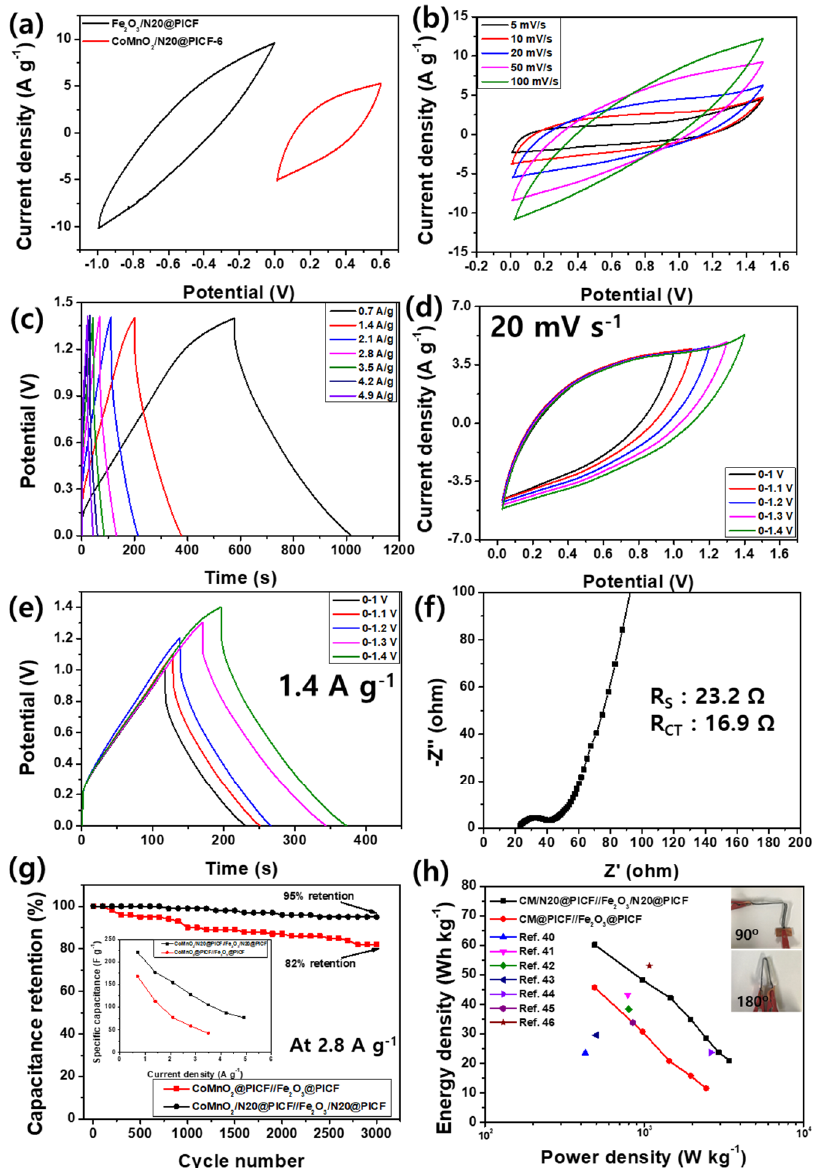
Figure 7. CV curves ( a ) of the cathode and anode materials at 20 mV s − 1 , CV curves ( b ) of the asymmetric supercapacitors (ASC) device at various scan rates, GCD curves ( c ) of the ASC device at di ff erent currents density, CV curves ( d ) at di ff erent potential windows at 20 mV s − 1 , GCD curves ( e ) at di ff erent potential windows at 1.4 A g − 1 , Nyquist plot ( f ) of the ASC device, cycle performance ( g ) of the ASC device for 3000 cycles at 2.8 A g − 1 (inset shows the relationship between specific capacitance and current density of the ASC device), ( h ) Ragone plot (inset shows the digital images of the ASC device upon bending).